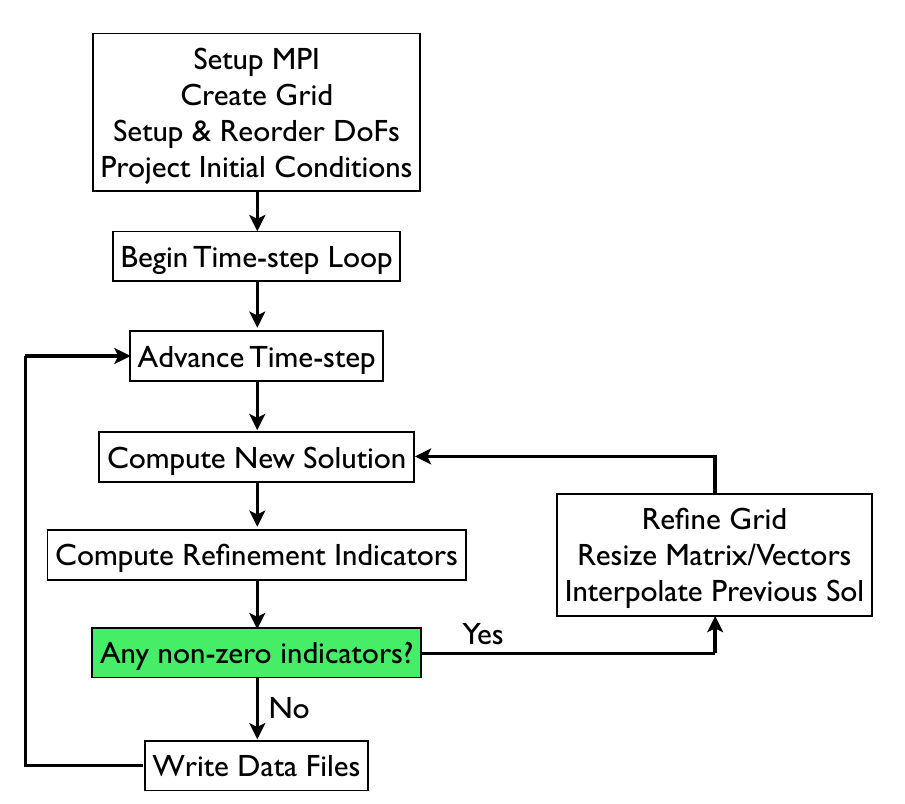
Figure 2 . Energy Release Rate based algorithm flow